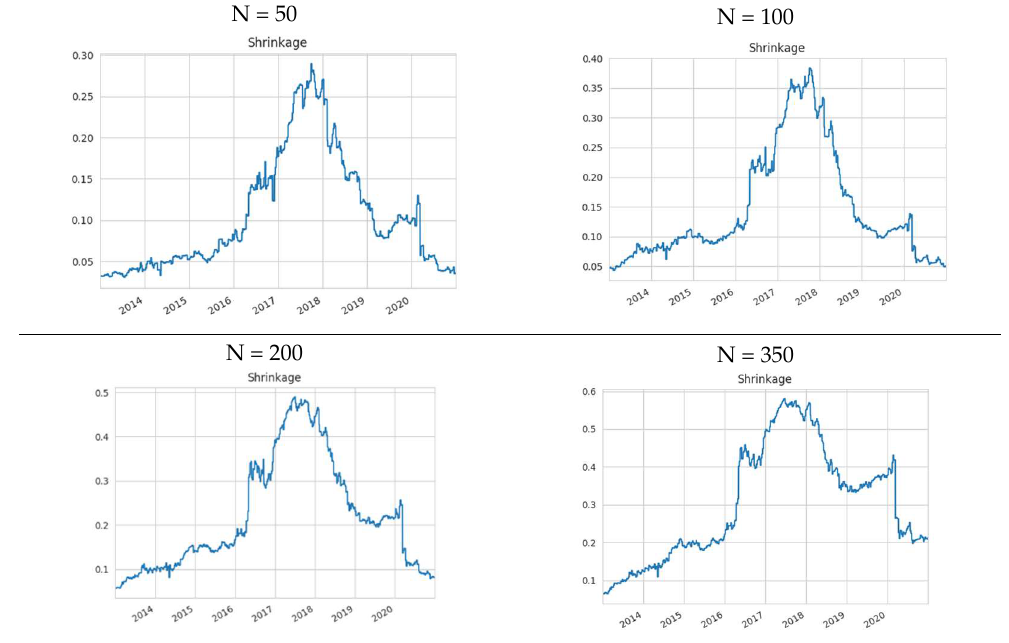
Table 5. The shrinkage coefficient in the period of 2013–2021.